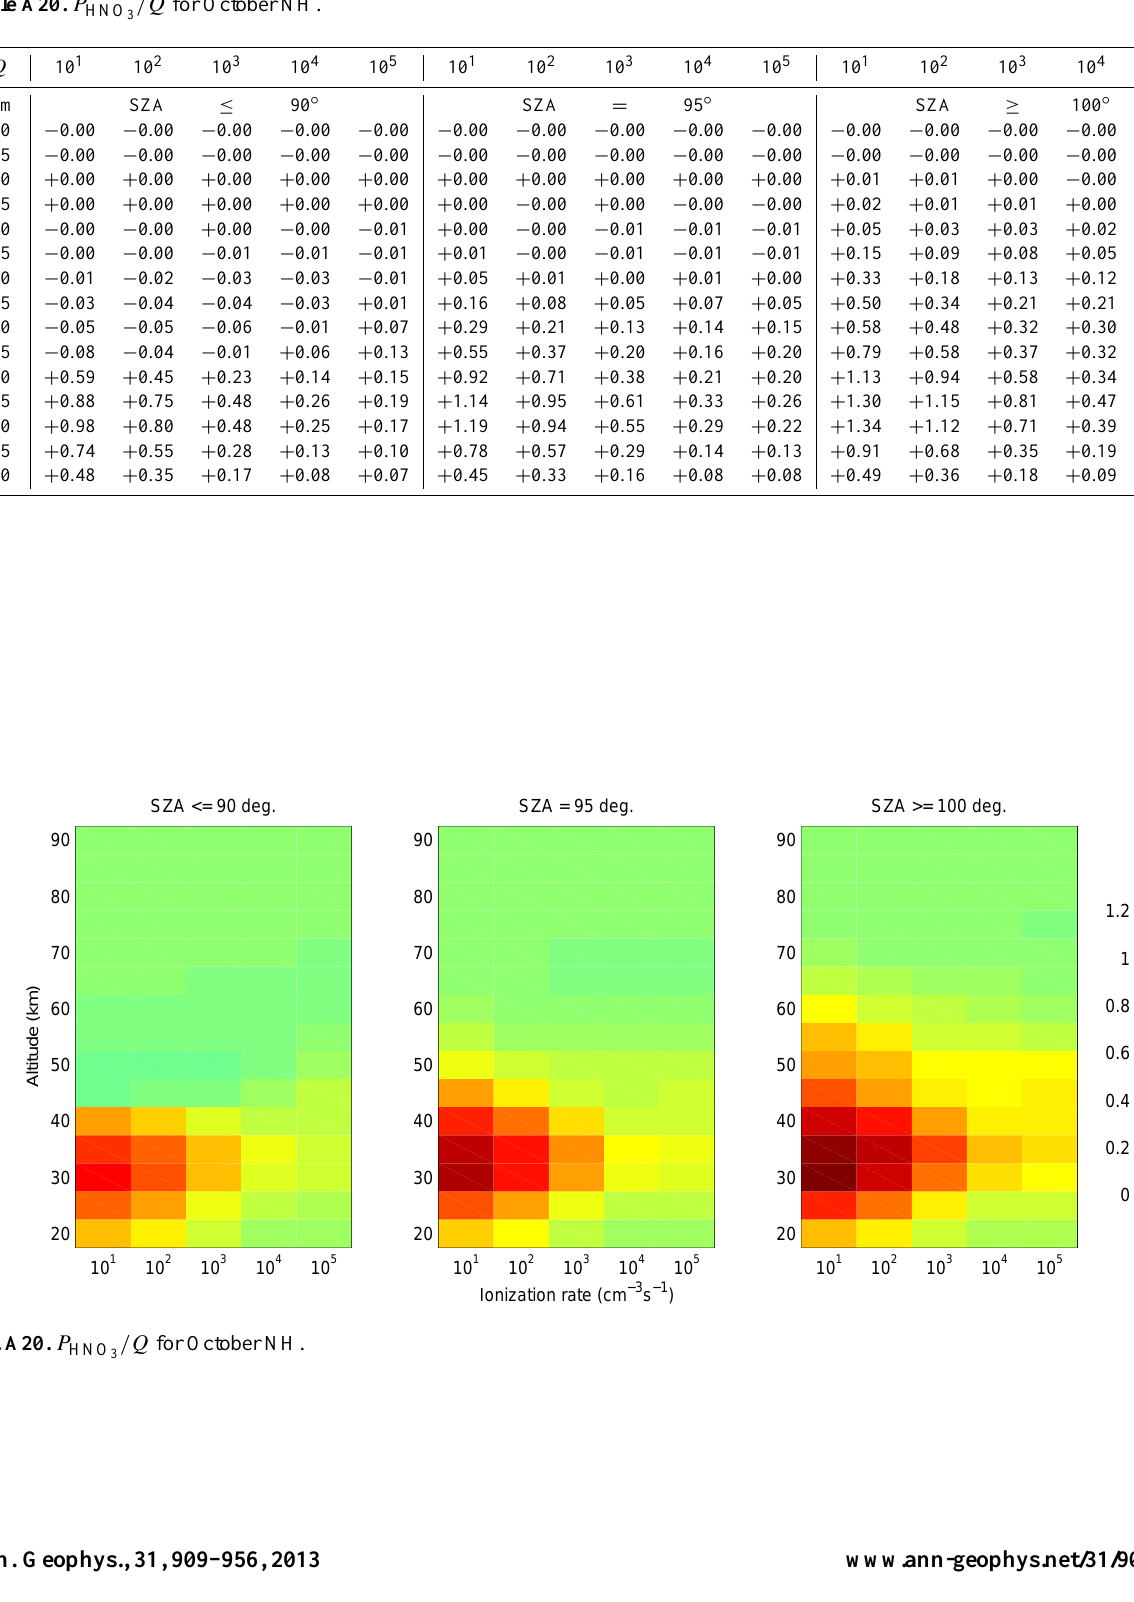
Table A20. P HNO